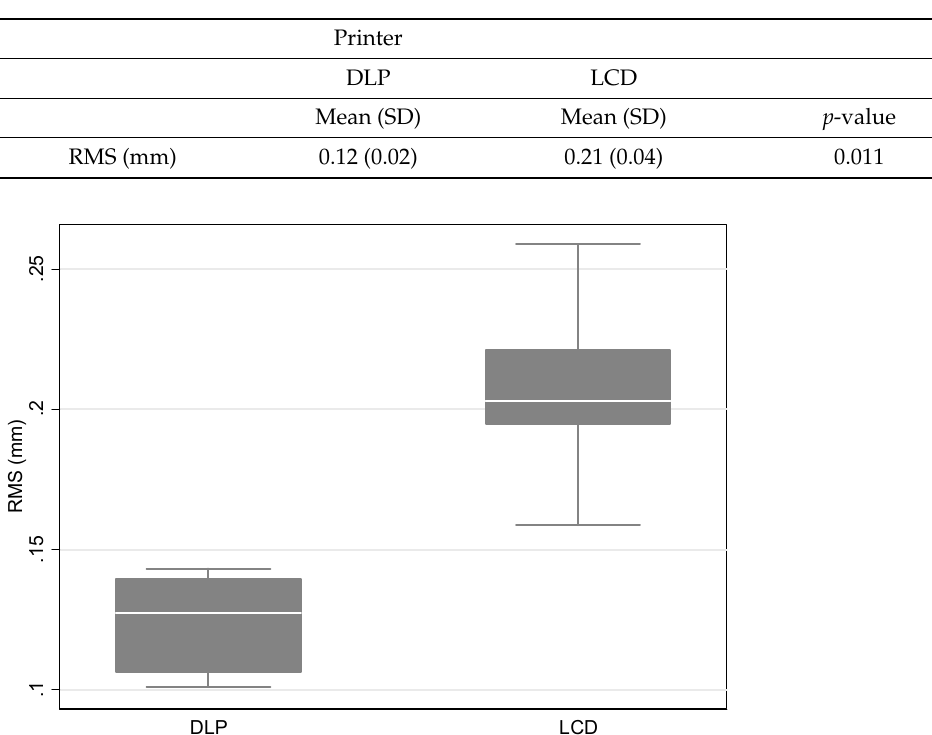
Table 2. Mean RMS value and standard deviation (SD) by printer type.